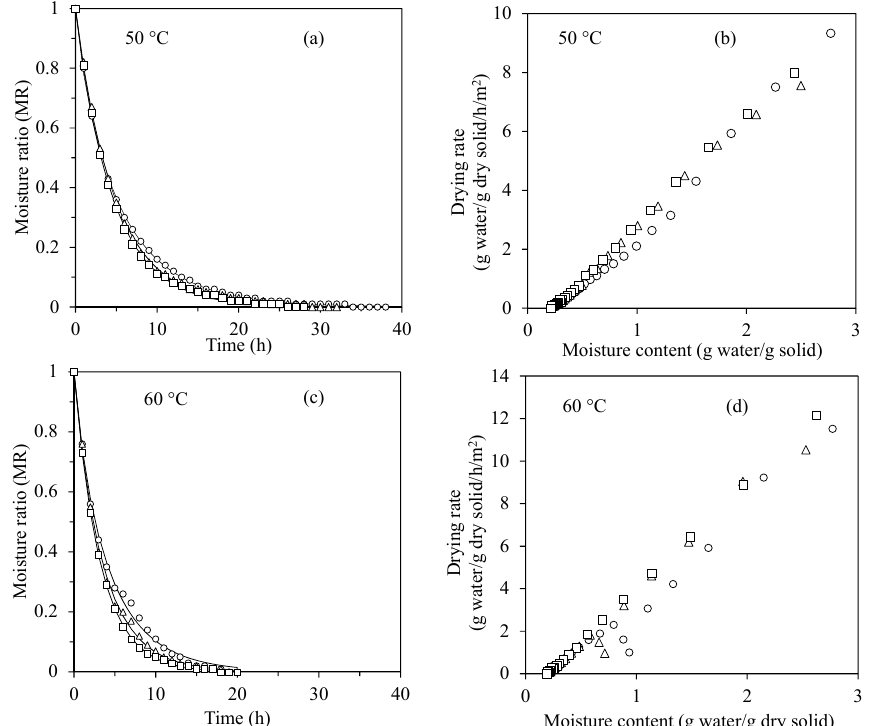
Figure 2. Drying curves ( a , c ) and drying rates ( b , d ) of ( ) fresh, ( ) quick frozen, and ( ) slow frozen mangoes at 50 and 60 °C in convective hot air dryer. Lines for drying curves were drawn using Page’s model. Table 2. Parameters ( k and n ) and their standard errors (s.e.) from Page’s model for describing dry ‐ ing behavior of mango slabs at 50 and 60 °C.